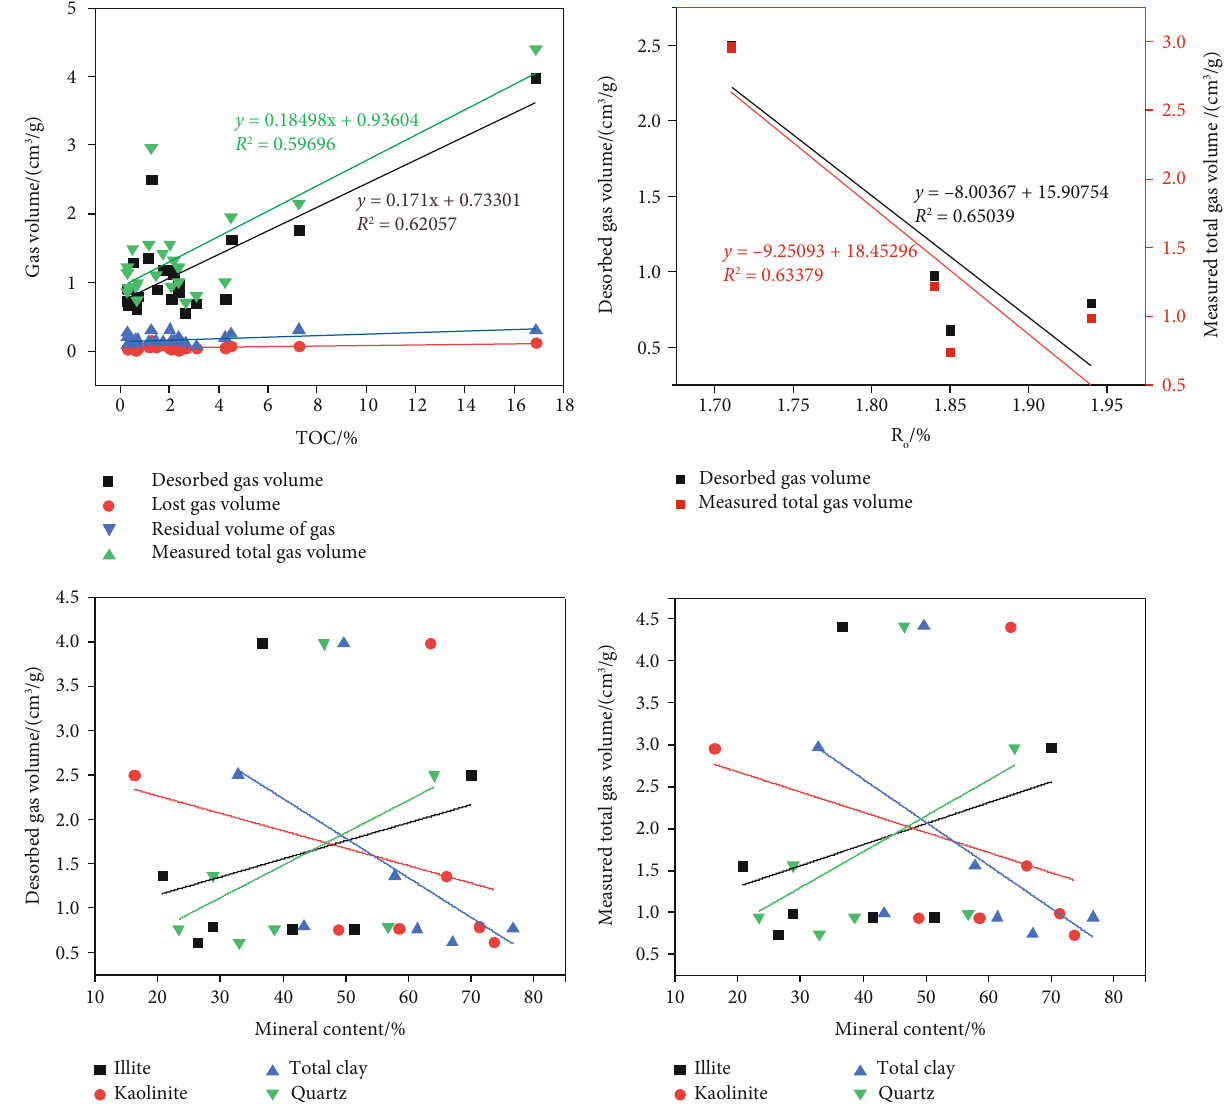
Figure 12: E ff ects of shale geochemical parameters and di ff erent components on gas